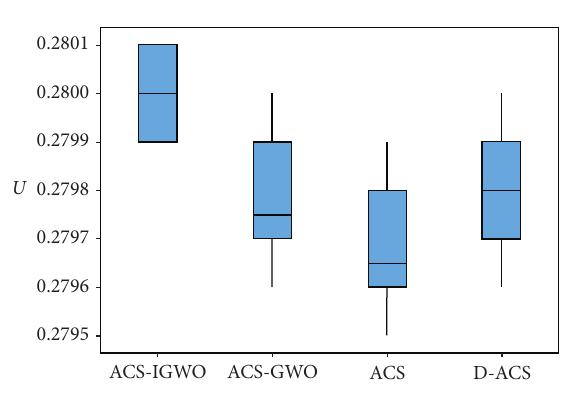
Figure 9: Box plot of example I.